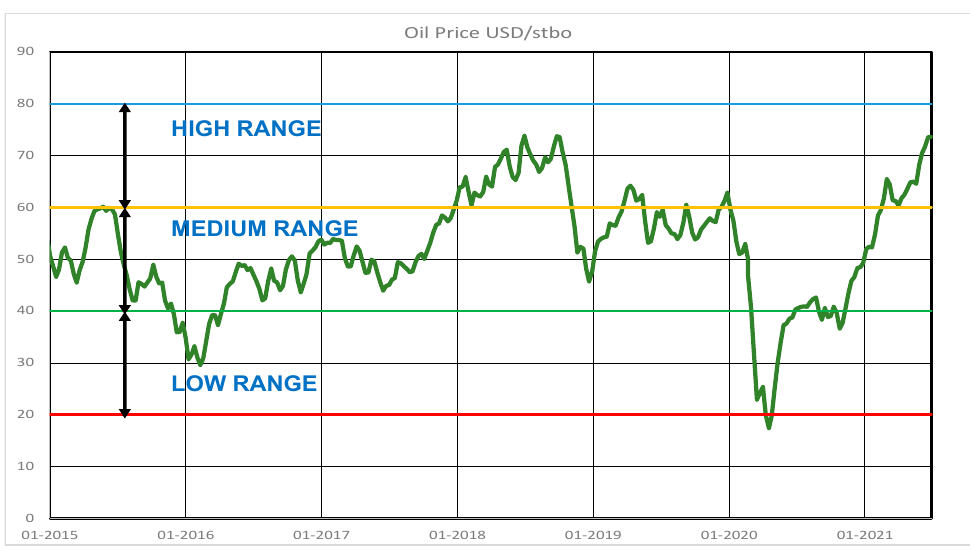
Figure 5. Oil price range breakdown. Applying the Integrated Workflow , for the four assumptions and three subintervals, the final table with the P50 results for the main business performance parameters is presented below (Table Table 6. The profitable sub-cases.